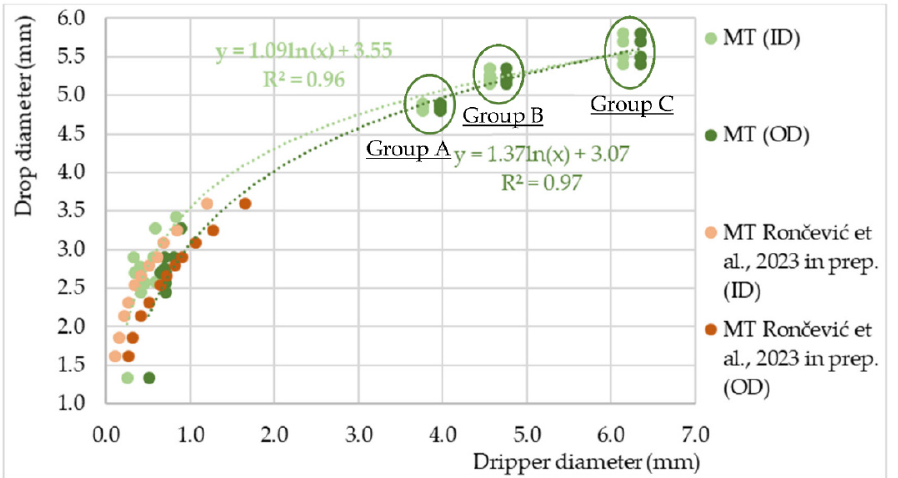
Figure 3. The influence of MT and PT drippers’ ID and OD size on the drop’s diameter with expanded diameter range (groups A, B and C) of MT drippers [67] in comparison to research of [65] Note: drippers whose corresponding drop diameters size were modified by the action of air, vibrations and inserted threads, and drops and drippers for which the diameter was given in a range, were excluded from the analysis. The equations shown exclude the data from the research of [65].